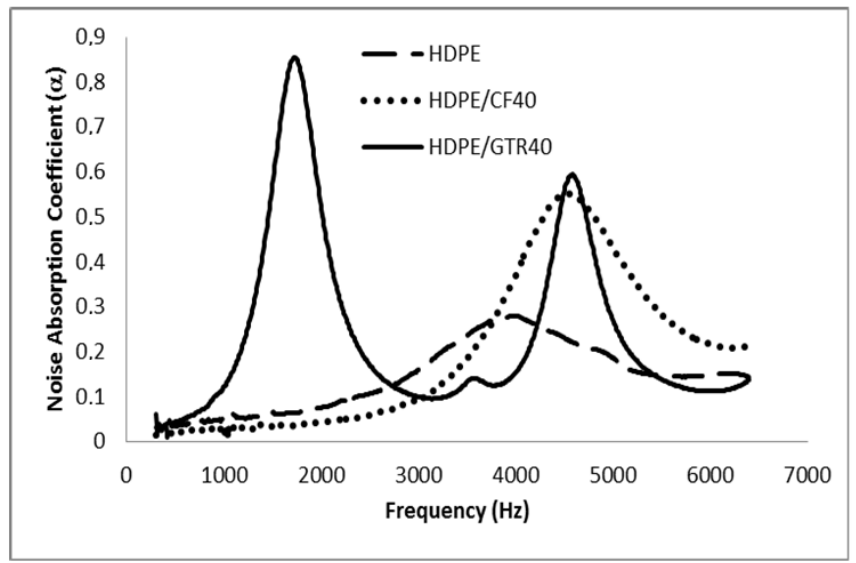
Figure 11. α values for HDPE and GTR/HDPE and CFs/HDPE composites at 40% composition.